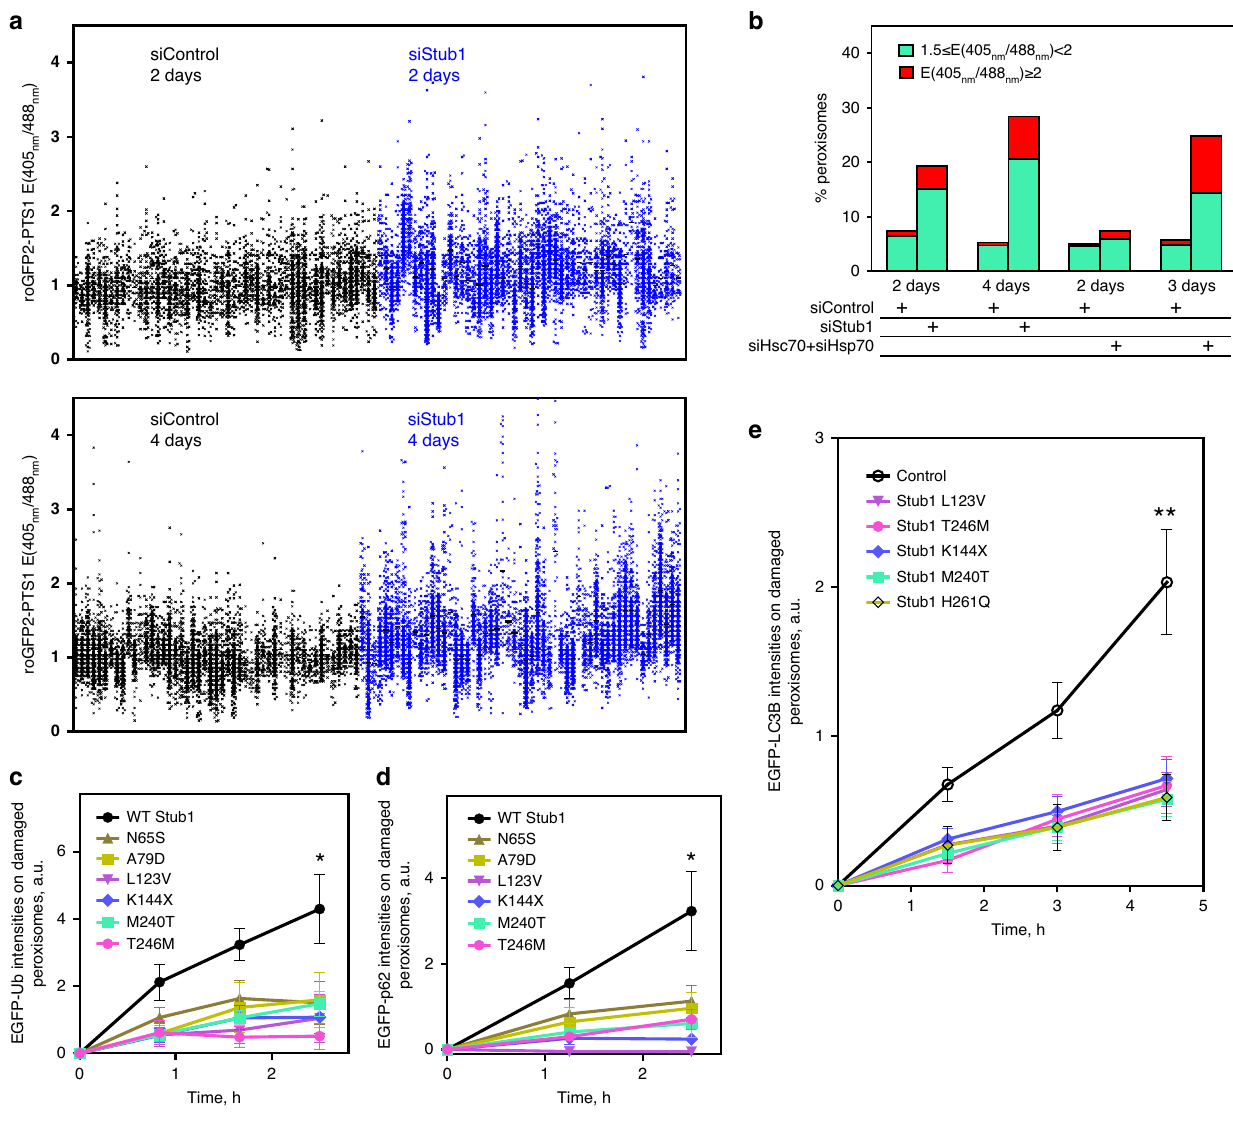
Fig. 7 Ataxia-related Stub1 mutants affect peroxisomal ROS-mediated pexophagy. a , b We assayed if Stub1 depletion affected peroxisome quality using NIH3T3 cells expressing a peroxisomal redox sensor roGFP2-PTS1. a roGFP2-PTS1 emission ratios between 405 and 488 nm excitation. Each dot represents one peroxisome, and a column denotes all peroxisomes within a single cell. The ratios in Stub1-depleted cells vs. those in control cells are shown (top: 48 h after depletion; bottom: 96 h after depletion). b Graph tabulating the percentage of peroxisomes with roGFP2-PTS1 ratios between 1.5 – 2 (green) and ≧ 2 (red). c , d The effect of WT and Ataxia-related Stub1 mutant overexpression on ubiquitin and p62 recruitment onto ROS-stressed peroxisomes in Stub1 KO (NIH3T3) cells. Stub1 KO cells expressed EGFP-Ub ( c ) or EGFP-p62 ( d ), plus TagBFP-PMP34, diKillerRed-PTS1, and WT hStub1 or Ataxia-related Stub1 mutants tagged with TagBFP. c WT, n = 11 cells; N65S, n = 14 cells; A79D, n = 9 cells; L123V, n = 8 cells; K144X, n = 9 cells; M240T, n = 11 cells; T246M, n = 6 cells. Each mutant vs. WT Stub1: N65S, P = 0.0123; A79D, P = 0.0315; L123V, P = 0.0143; K144X, P = 0.0066; M240T, P = 0.0119; T246M, P = 0.0023 (one-tailed t test). d WT, n = 13 cells; N65S, n = 10 cells; A79D, n = 13 cells; L123V, n = 10 cells; K144X, n = 11 cells; M240T, n = 9 cells; T246M, n = 12 cells. Each mutant vs. WT Stub1: N65S, P = 0.0259; A79D, P = 0.0186; L123V, P = 0.0021; K144X, P = 0.0038; M240T, P =